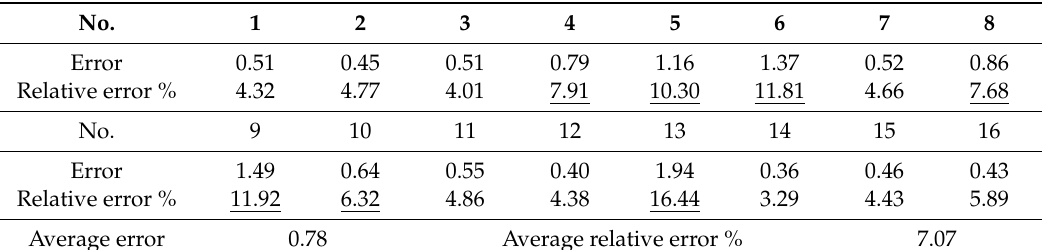
Table 7. Prediction error of M LS